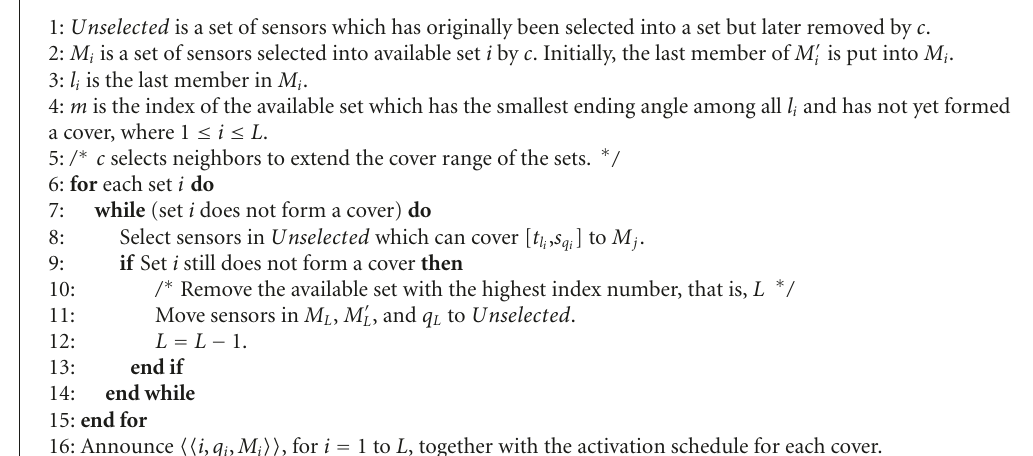
Algorithm 2: Pseudocode of c = q (cid:9) receives message (cid:10)(cid:10) 1, q 1 , M (cid:9) 1 (cid:11) , ... , (cid:10) L , q L , M (cid:9)